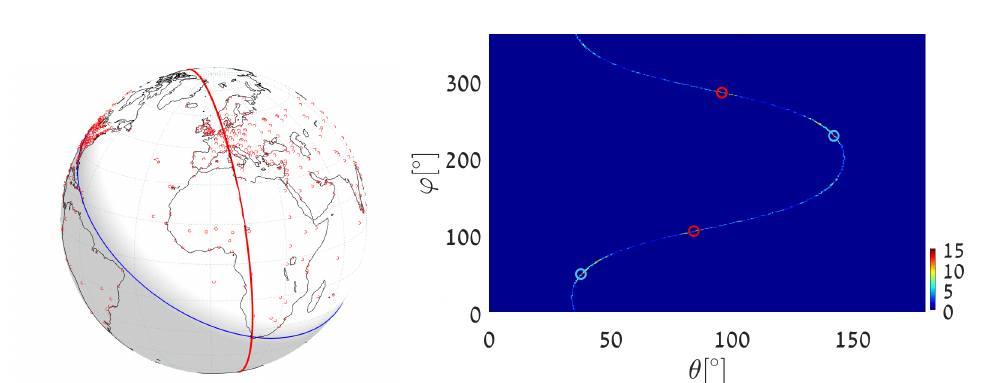
Figure 22. ( Left ) Detecting the great circle (blue) passing through Cape Town International Airport and passing through the maximum number of other airports, using almost-equal-sized cell quantiza- tion. The red circle corresponds to the second maximum, following the unvoting process. ( Right ) Heat plot of the accumulator array M along the θ ( ϕ ) curve corresponding to Cape Town airport, showing the parameters of the two great